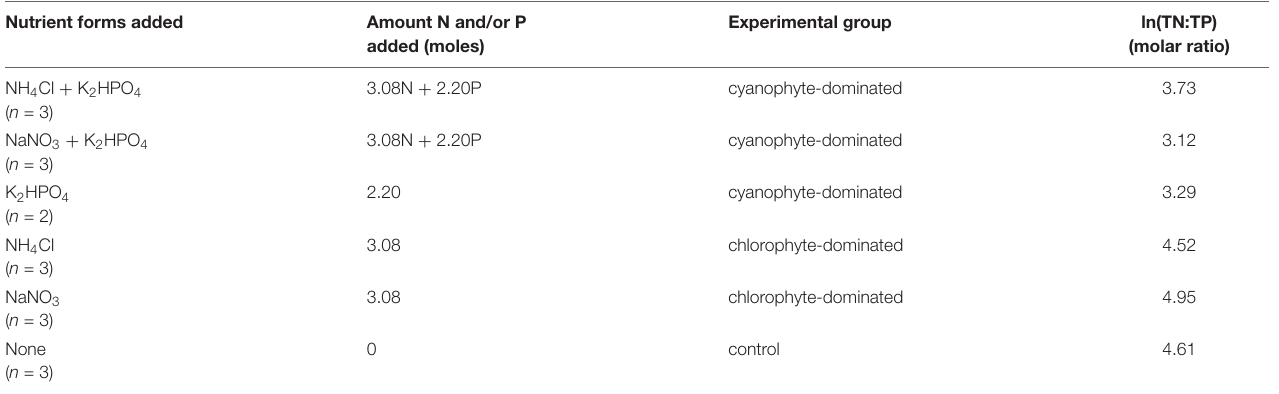
TABLE 1 | Experimental design to promote phytoplankton growth through nutrient amendments. Nutrient forms